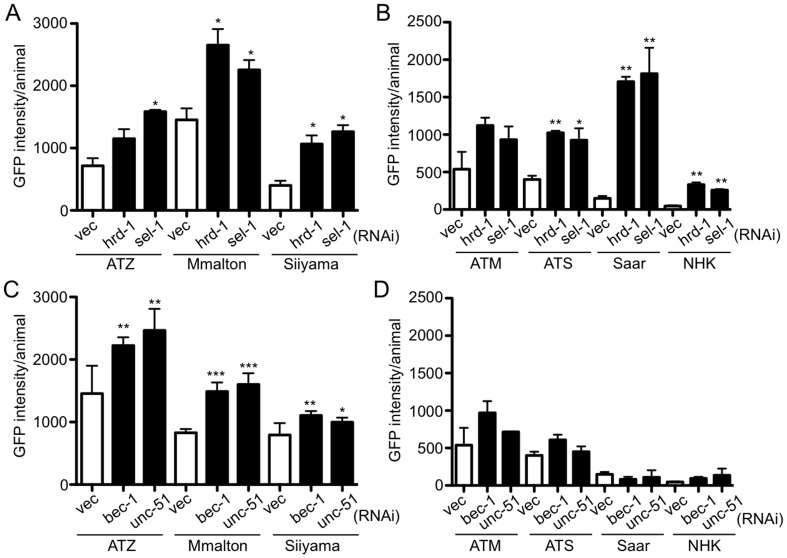
Proteostasis pathways used to clear AT variant proteins.Effect of ERAD (hrd-1 or sel-1) RNAis on clearance of deficient (A) and null variants (B). Effect of autophagy (bec-1 or unc-51) RNAis on clearance of deficient (C) and null variants (D). The data is representative of 6 experiments. Statistical significance was determined by comparing treatments to their respective vec(RNAi) controls using an unpaired, two-tailed students t-test, *P<0.05, **P<0.01, and ***P<0.001.